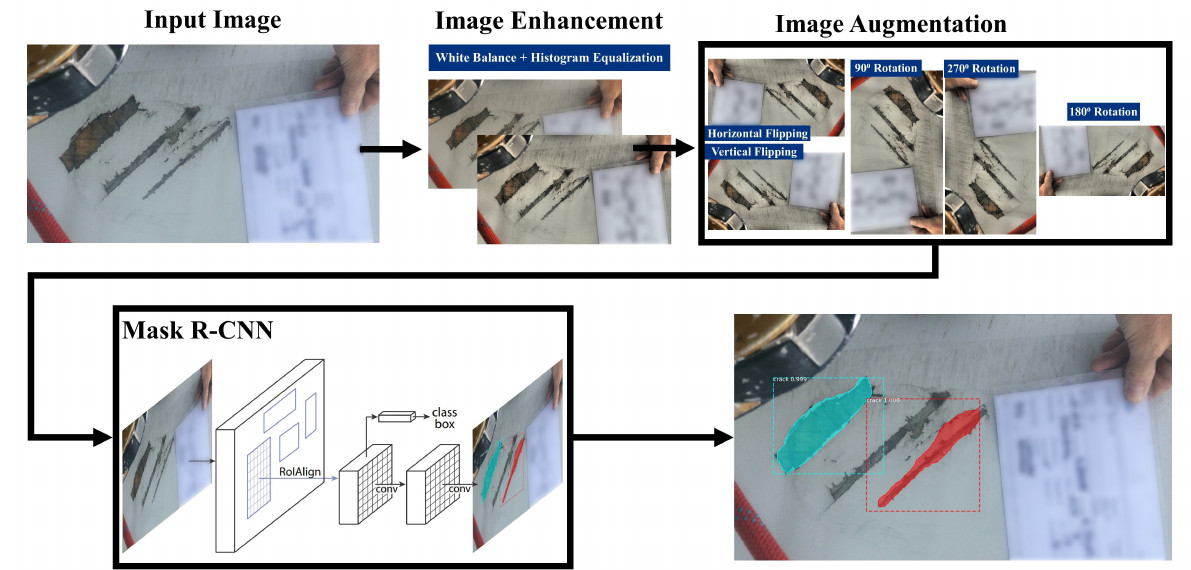
Figure 5. IE Mask R-CNN: The proposed Image Enhanced Mask R-CNN